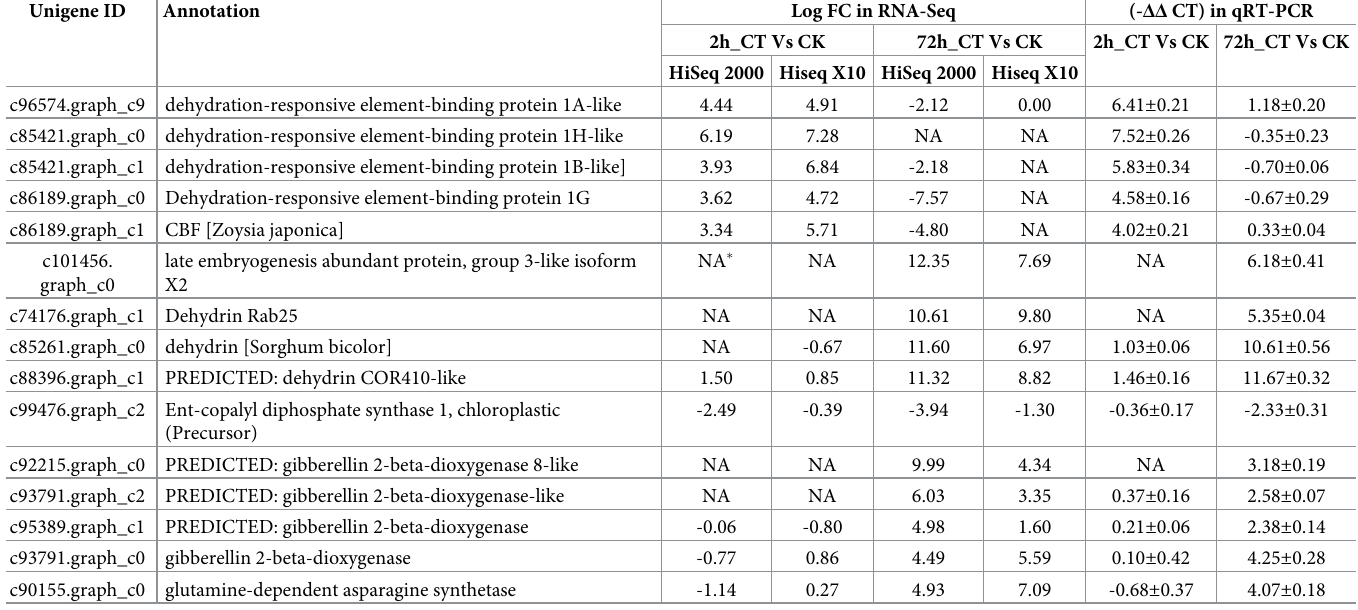
Table 4. Verification of RNA-seq results by